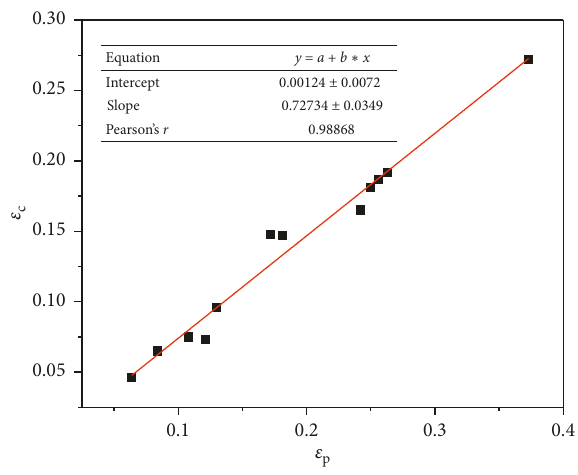
Figure 9: Relationships between ε